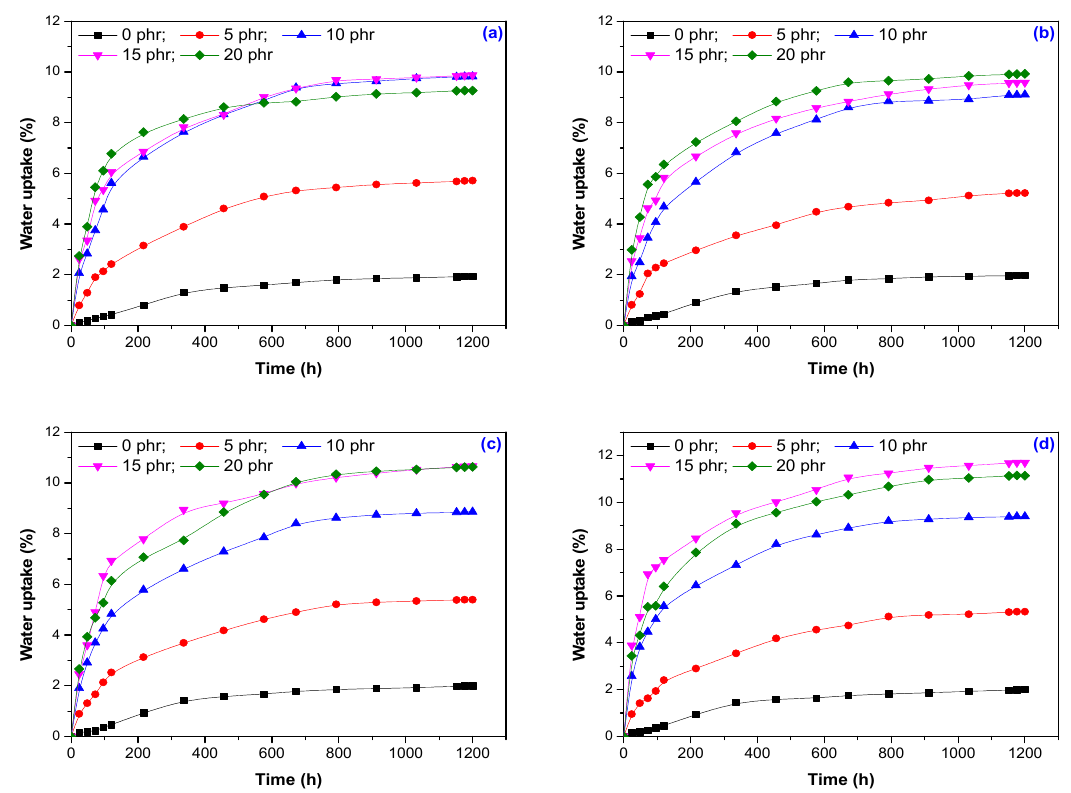
Figure 11. Water uptake of composites based on EPDM and hemp fiber versus immersion time for irradiation doses of ( a ) 75 kGy; ( b ) 150 kGy; ( c ) 300 kGy and ( d ) 600 kGy.